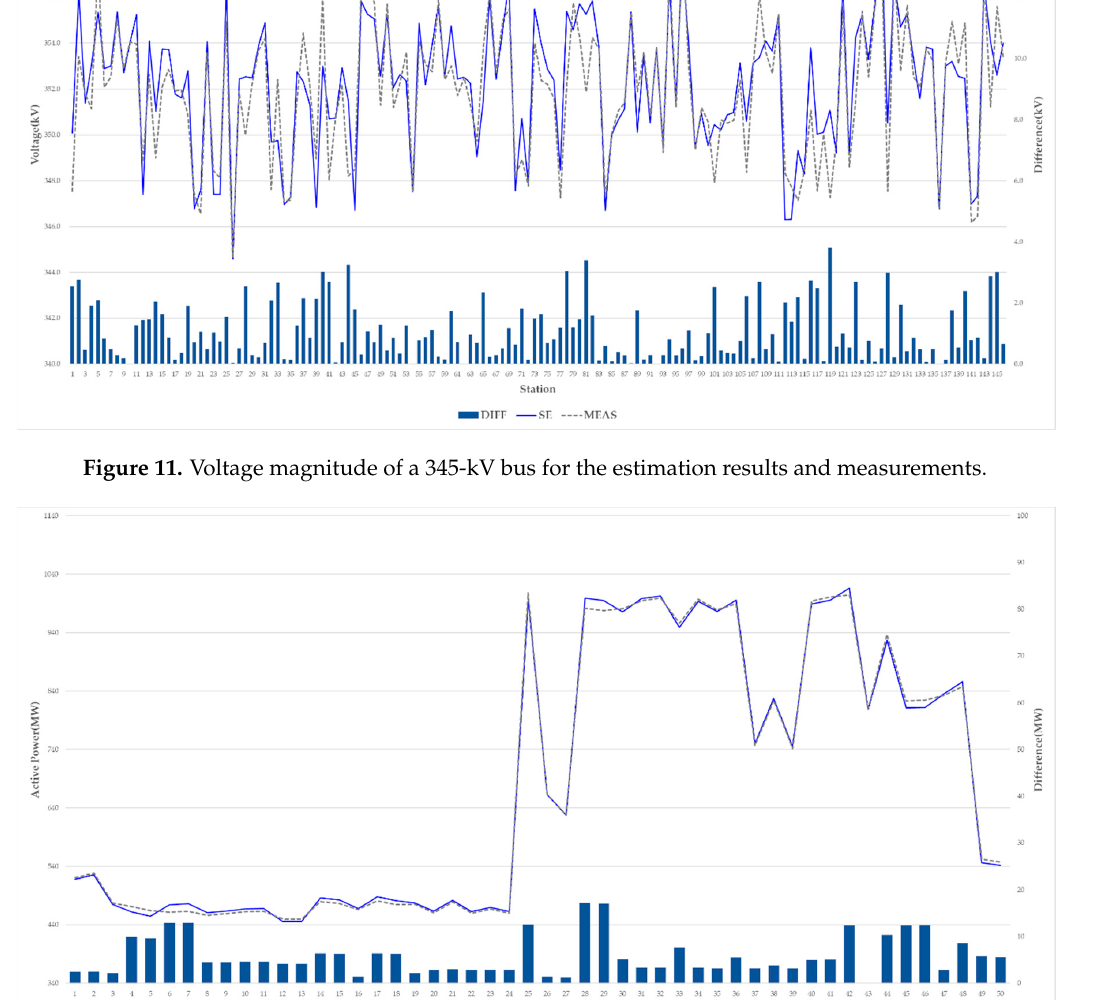
Figure 13. Branch flow for the estimation results and measurements of the 50 largest trans. lines. The performance of the state estimation of the REMS was evaluated using the refer- ence of the state estimation of ERCOT [26], which is among the system operators in the United States with a high penetration of renewable energy. The installed capacity of re- newable energy in 2020 year is 35,114 MW. The reasons for selecting the reference of the state estimation of ERCOT in this paper are as follow. First, Korea Power eXchange (KPX) operates the power system based on EMS. To analyze and maintain the performance of generation, voltage and power flow, KPX has established the reference of state estimation based on ERCOT and other ISOs. KPX up- dates the EMS function by benchmarking ERCOT cases in terms of the penetration of re- newable energy. Second, Korea has recently announced the target of 78.1 GW of renewa- ble energy by 2034. Since most of the large-scale renewable energy is wind power, ERCOT with high penetration of wind power is a good reference. Third, loads are concentrated in the metropolitan area in Korea. The transmission lines connecting the metropolitan area